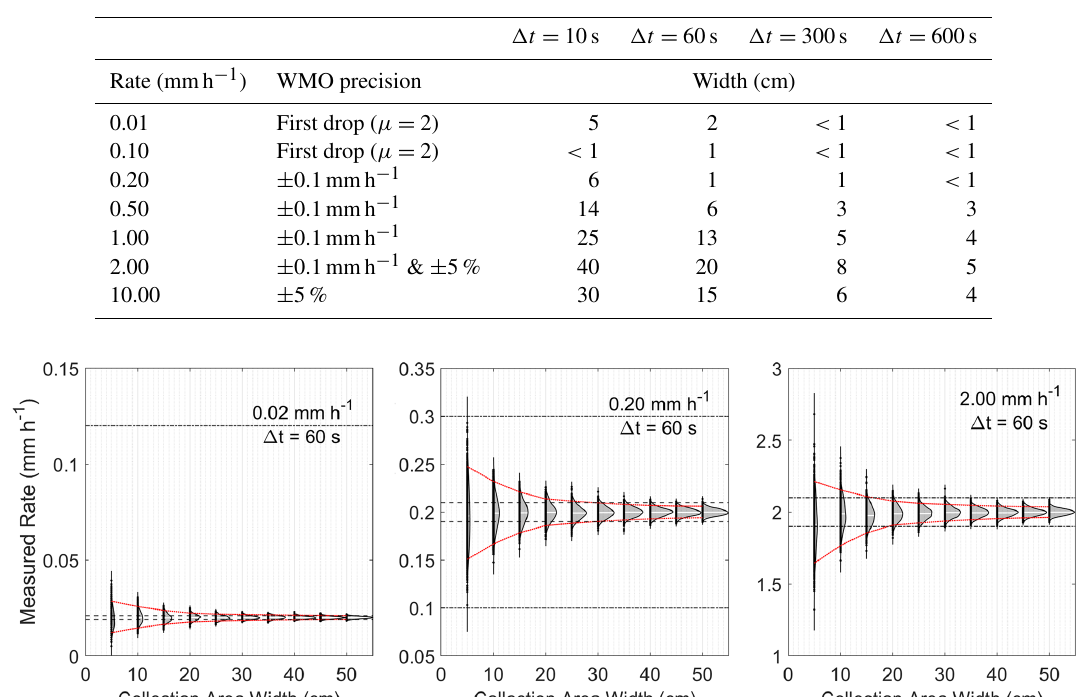
Table 2. Minimum collection area required to meet WMO precision criteria for various precipitation rates and time intervals evaluated within 1cm intervals.